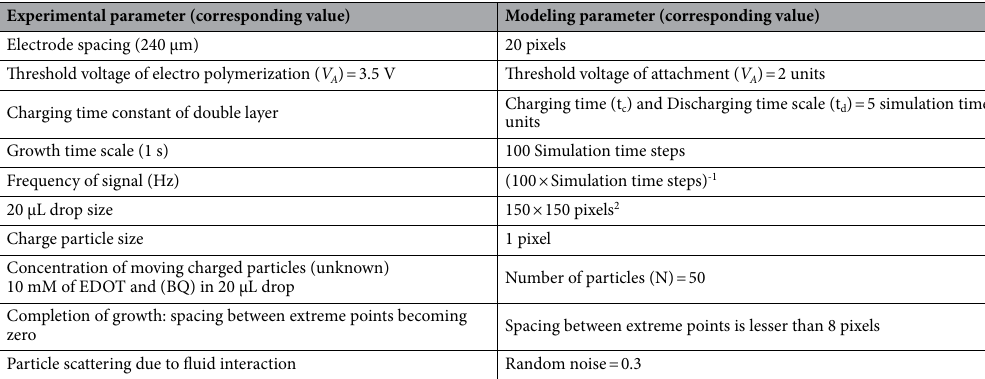
Table 1. Simulation parameters used in the study compared with the corresponding experimental